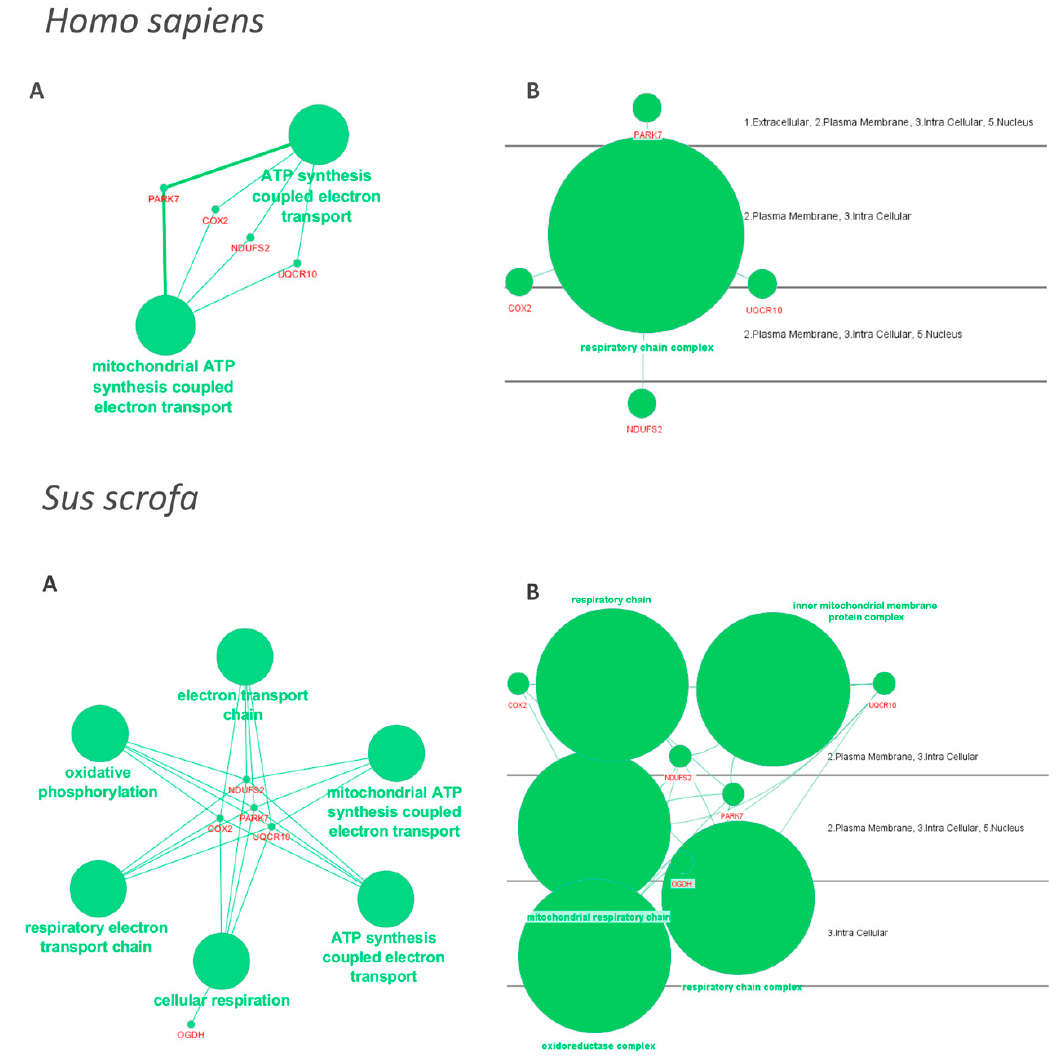
Figure 4. Networks highlighting the most relevant protein–protein interactions among those differentially abundant pig sperm proteins, comparing fresh and frozen-thawed ejaculated spermatozoa. The network was generated using Cytoscape and the ClueGO plug-in considering the database proteins of Homo sapiens or Sus scrofa. The networks were generated for functional ( A ) and subcellular localization ( B ) categories with the terms represented as nodes linked based on their κ -score level ( ≥ 0.4) is shown. The node size represents the relevance of enrichment.